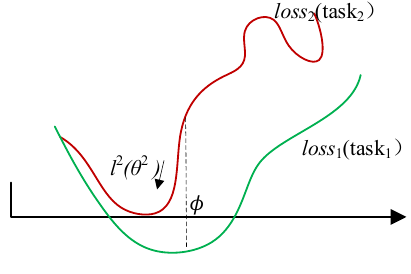
Figure 3. Descend to the global optimum.